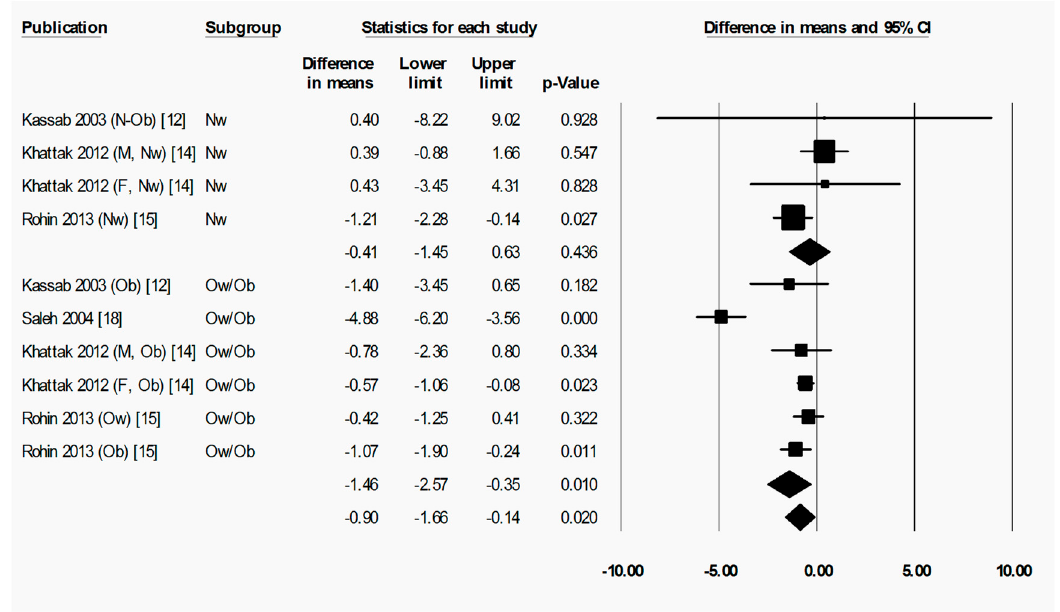
Figure 3. Fat percentage was significantly decreased by Ramadan fasting in the overweight/obese but not in the normal weight subgroup. Change in fat percentage (%) as subdivided by BMI category (normal weight and overweight/obese), between pre-Ramadan (pre-R) and the end of Ramadan (post-R). There was no significant difference between normal weight and overweight/obese subgroups ( p = 0.178). Heterogeneity statistics: normal weight T = 0.508, p = 0.280, I 2 = 21.7%; overweight/obese T = 1.536, p < 0.001, I 2 = 86.8%. F = female; M = male; Nw = normal weight; Ow = overweight; Ob = obese; N-Ob = non-obese.